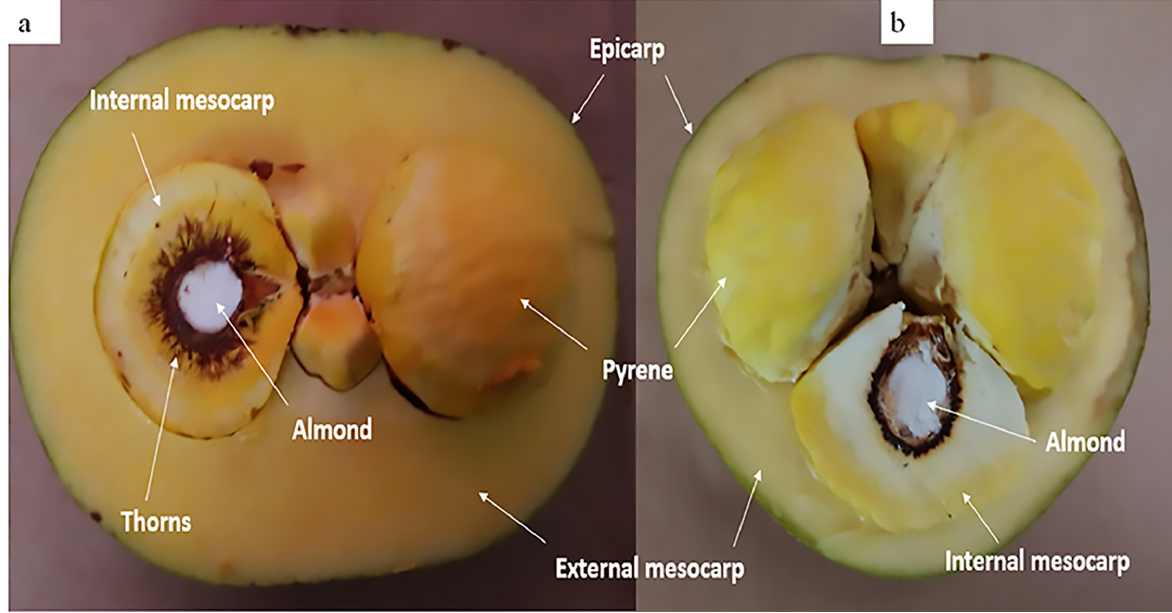
Figure 1. Morphological aspects of pequi ( Caryocar brasiliense ). a: with thorns, and b: without